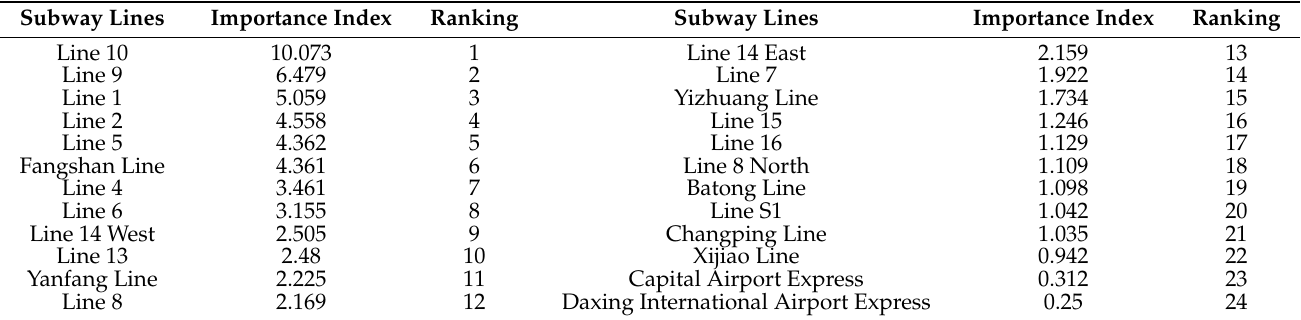
Table 12. Line importance index of Beijing